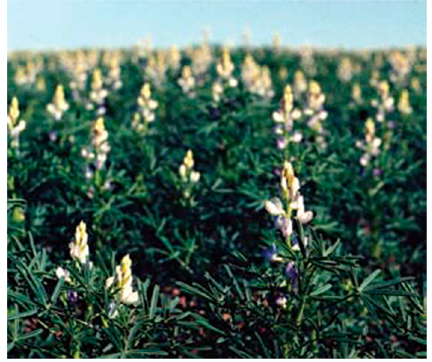
Figure 2. Lupinus angusifolius (narrow-leafed lupin), Photo: P. White.